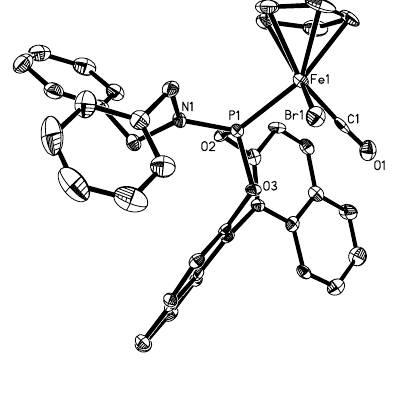
Figure 2. Molecular structure of one of the diastereomers of 4b (depicted with 65% probability ellipsoids, H atoms, and solvents are omitted for clarity). Key bond lengths and bond angles are listed in Table